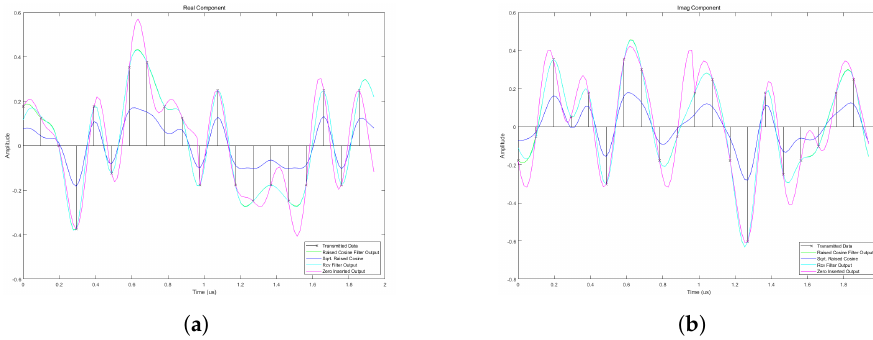
Figure 12. Up-sampling process demonstration for a short time. ( a ) Signals’ Real Components Comparison. ( b ) Signals’ Imagine Components Comparison.